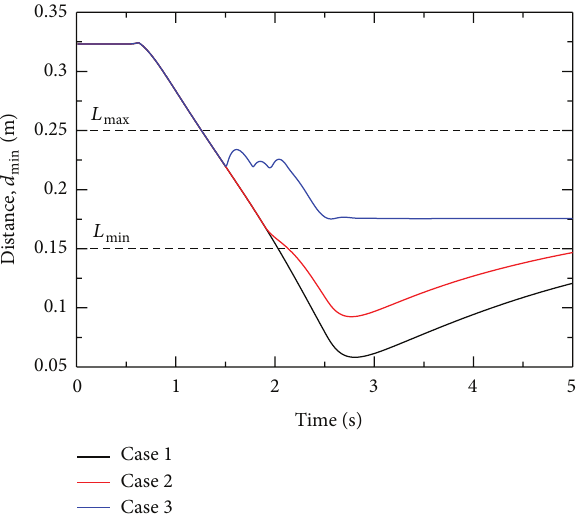
Figure 12: Distance 𝑑 min in Cases 1, 2, and